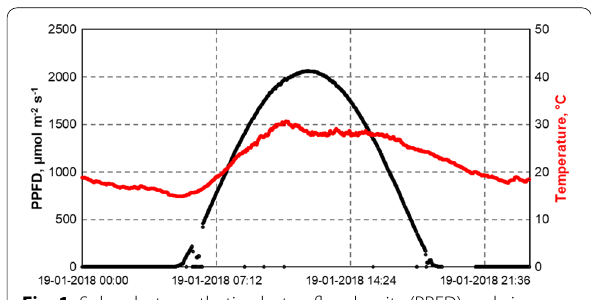
Fig. 1 Solar photosynthetic photon flux density (PPFD) and air temperature. Data recorded in Newcastle, Australia, on January 19, 2018 by BSRN station no: 52. Data were provided by Duck (2018) (BSRN). All batch processes in flat‑plate gas‑lift photobioreactors were performed under these repeatedly applied